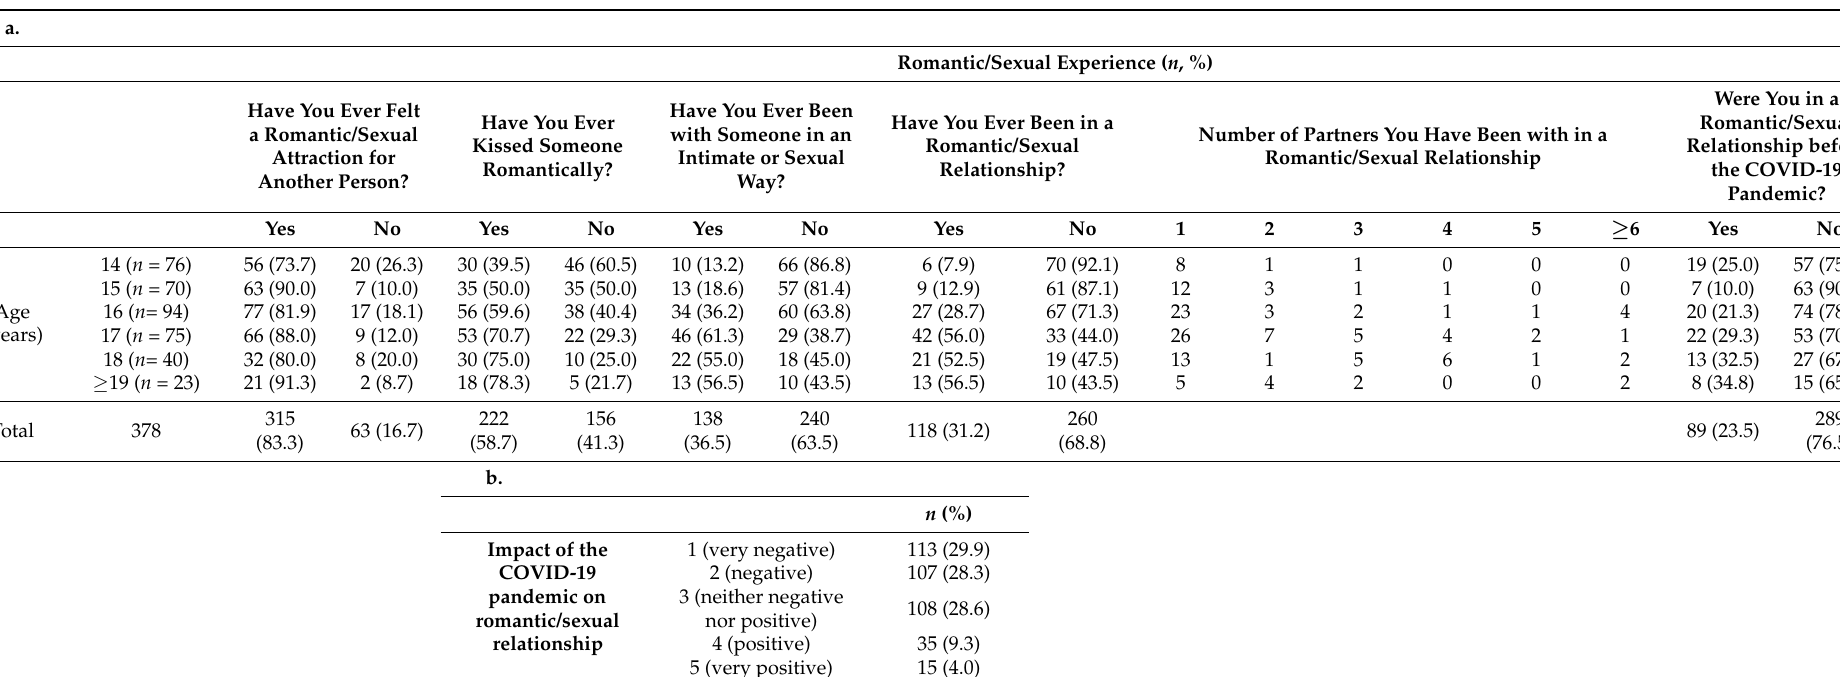
Table 2. Sexual experiences among adolescents in the Metropolitan City of Bologna (a) and changes in the romantic/sexual relationships during the COVID-19 pandemic